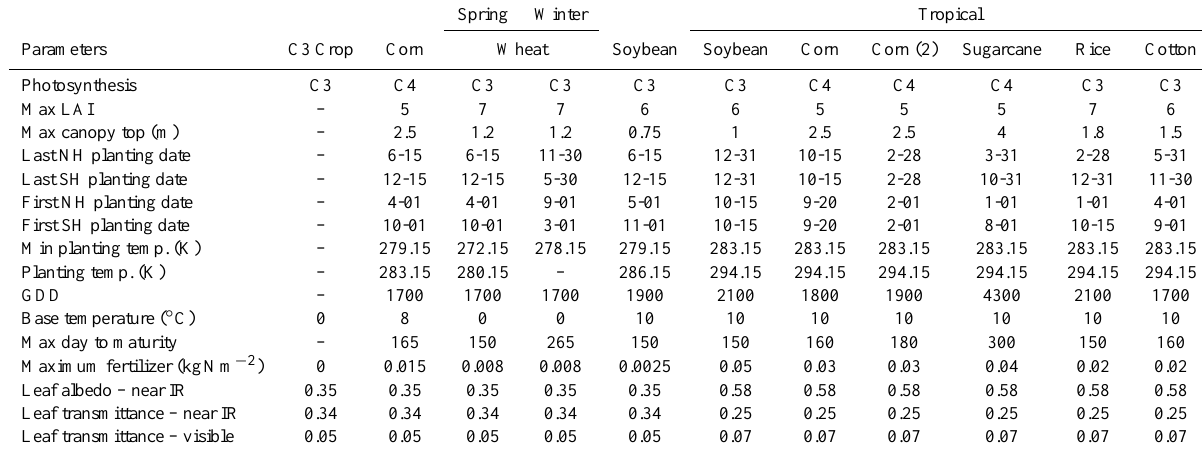
Table 1. Key parameters used in developing CLM4.5 tropical crops. Planting dates are in the format of month-day (example: 4-15 is 15 April). “–” denotes a parameter that is not